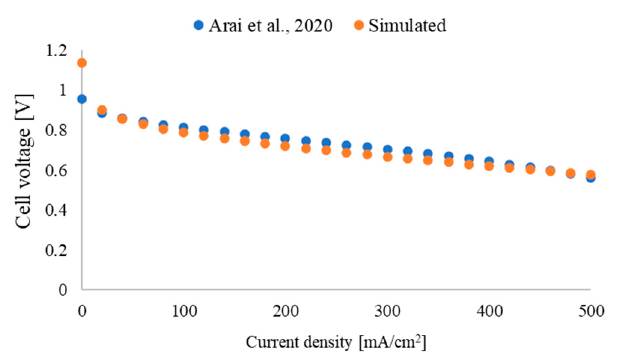
Figure 2. The comparison of I-V characteristics of initial state between simulated value using present study models and experimental value conducted by Arai et al. [36], under 50 °C and 100% RH con- ditions.